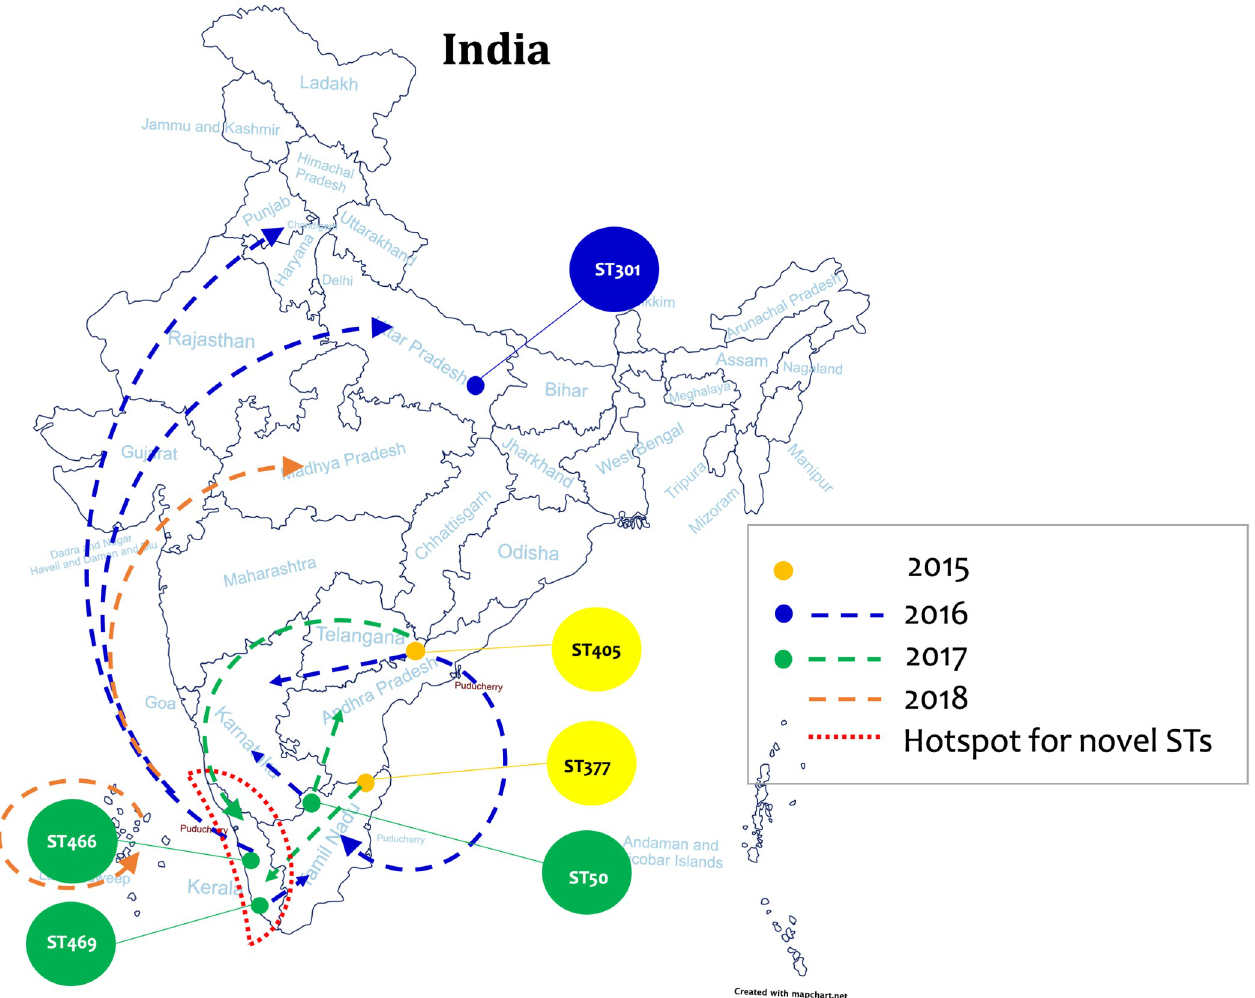
Fig 3. Illustration of the probable routes of transmission of STs identified in this study. The coloured circles represent the first occurrence of the ST and the dotted arrow with colour indicates the possible transmission routes according to the year of isolation. The red dotted lines highlight the hotspot for novel sequence types. Map outline was created using mapchart.net. Republished from mapchart.net under a CC BY license, with permission from MapChart, original copyright